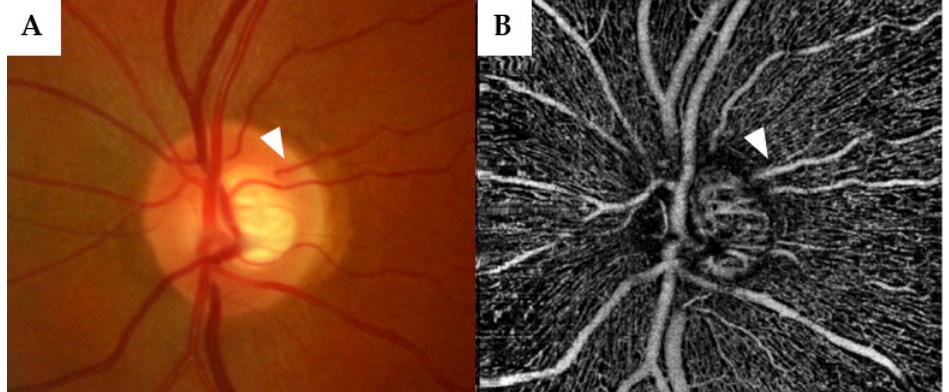
Figure 1. Fundus imaging ( A ) and optical coherence tomography angiography (OCTA) ( B ) in a 51-year-old male primary open-angle glaucoma patient show a cilioretinal artery (arrowhead) at the temporal rim of the optic nerve head without a connection with the central retinal artery.